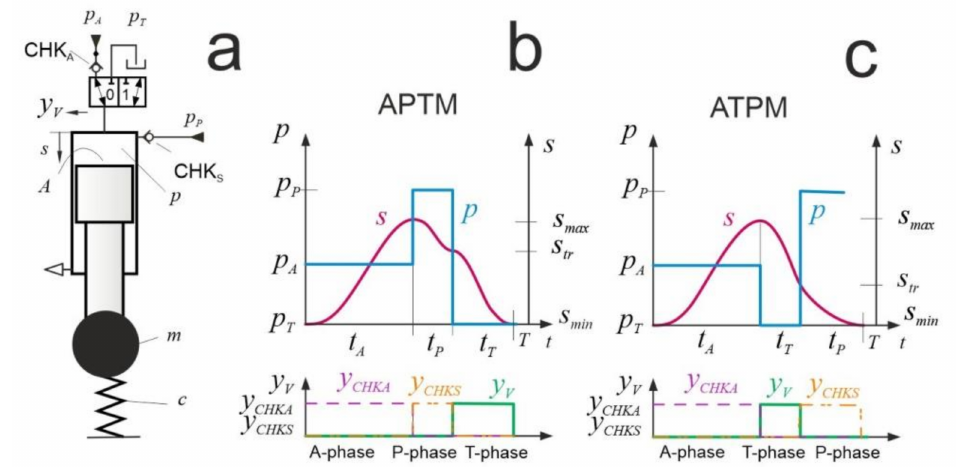
Figure 3. ( a ): Oscillating mass converter (OMC) concept of a one quadrant step up converter; piston motion s(t), cylinder pressure p(t) , and valve switching diagrams for two operation modes (( b ): oper. sequence A-P-T (APTM), ( c ): oper. sequence A-T-P